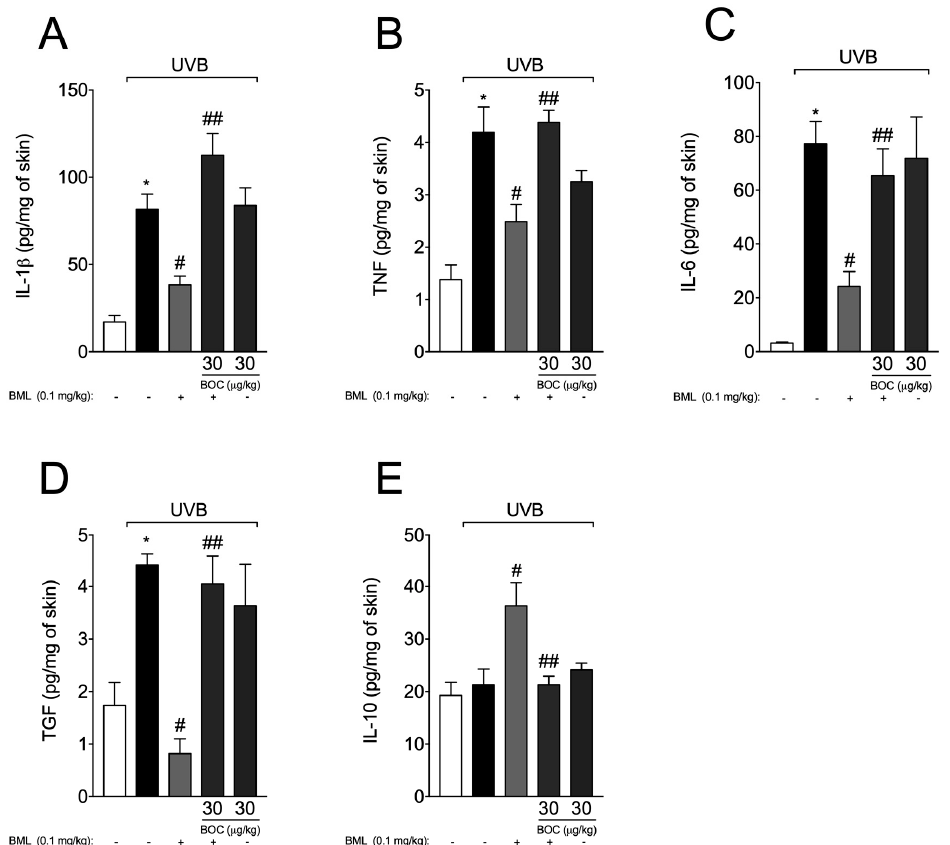
Figure 6. BML-111 reduces cytokine production during UVB-induced skin inflammation . Skin samples were dissected 4 h after the radiation to determine the levels of IL-1 β ( A ), TNF- α ( B ), IL-6 ( C ), TGF ( D ),